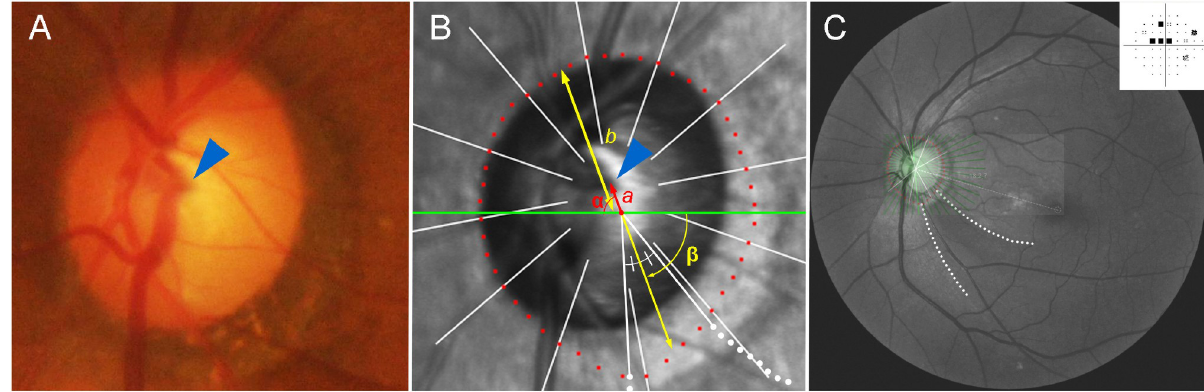
Fig 1. Measurement of central retinal vascular trunk (CRVT) deviation. ( A ) Disc photograph. The arrowhead indicates the emergence of the CRVT. ( B ) Infrared image obtained by spectral-domain optical coherence tomography (SD-OCT) with demarcated margin of Bruch’s membrane opening (BMO). The red dots indicate the BMO margin, and the green line indicates the reference line. The angular deviation of the CRVT ( α ) is measured clock-wise, with the nasal horizontal midline as 0˚. A positive value indicates the superior location, and a negative value indicates the inferior location relative to the reference line. The angular location of retinal nerve fiber layer (RNFL) defect ( β ) is measured clock-wise, with the temporal horizontal midline as 0˚. A positive value indicates the superior location and a negative value indicates the inferior location relative to the reference line. From the BMO center, the distances are measured to the CRVT ( a ) and to the BMO margin in the same direction ( b ). The ratio of these distances was defined as the ‘offset index’ ( a / b ), which was used to measure the extent of offset. ( C ) Red-free fundus photo. A singular RNFL defect is observed in the inferior hemisphere (between the dotted lines). An infrared SD-OCT image is transposed to show the BMO margin. The Humphrey visual field result shows superior scotomas corresponding to the inferior RNFL defect.